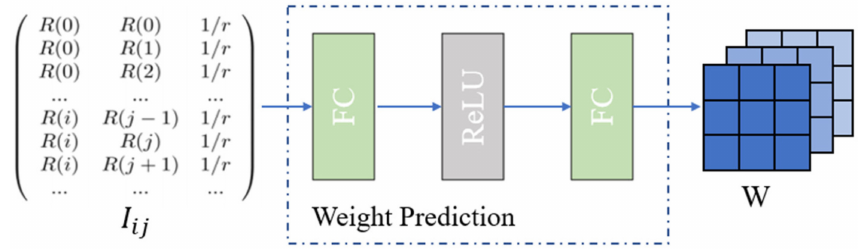
Figure 7. Weight prediction network schematic